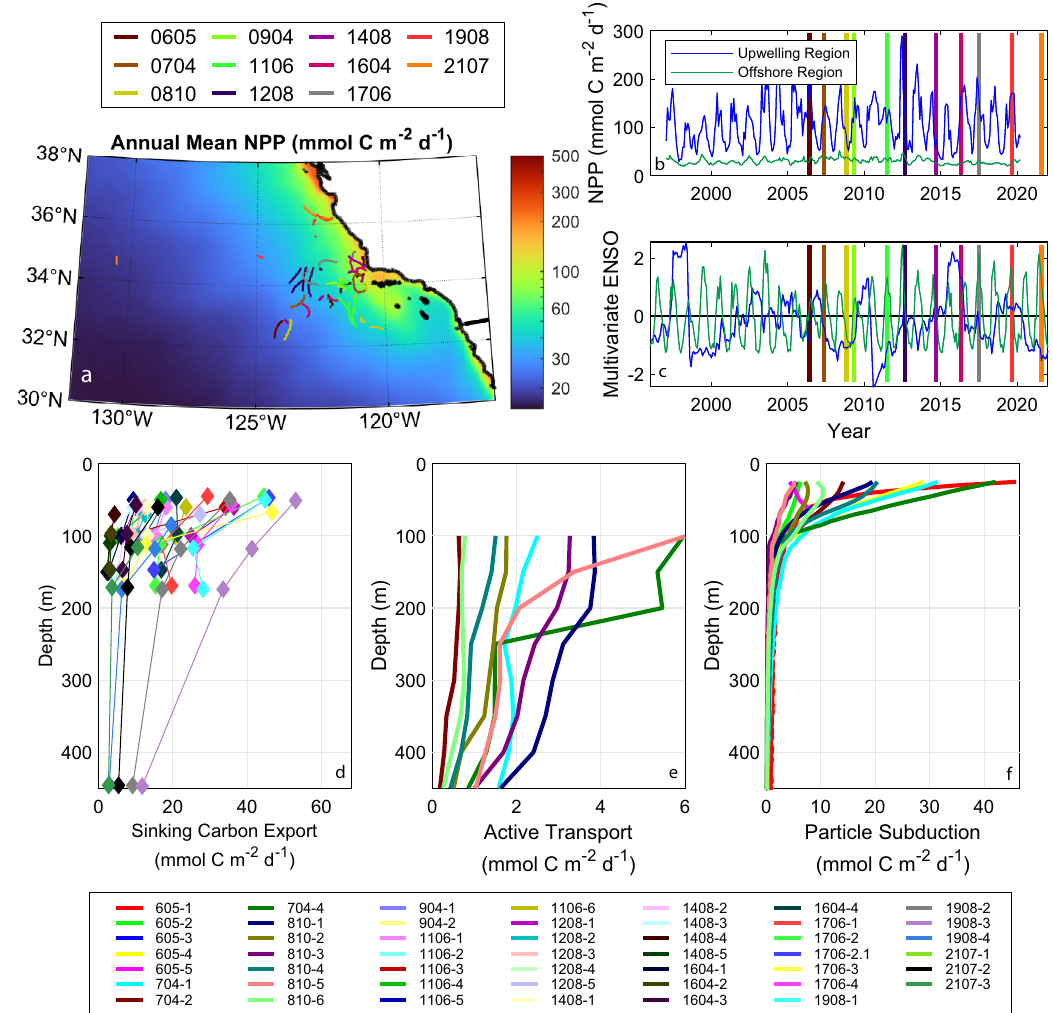
Fig. 1 | Spatiotemporal variability in California Current Ecosystem properties andcarbonexport.a Spatialmapofmeannetprimaryproduction(NPP) 64 . b Time- series of net primary productivity near the Point Conception upwelling center and in the offshore, oligotrophic region. c Time-series of the multivariate El Niño- Southern Oscillation index and normalized Bakun upwelling index. d – f Carbon export via d sinking particles, e active transport mediated by diel vertically